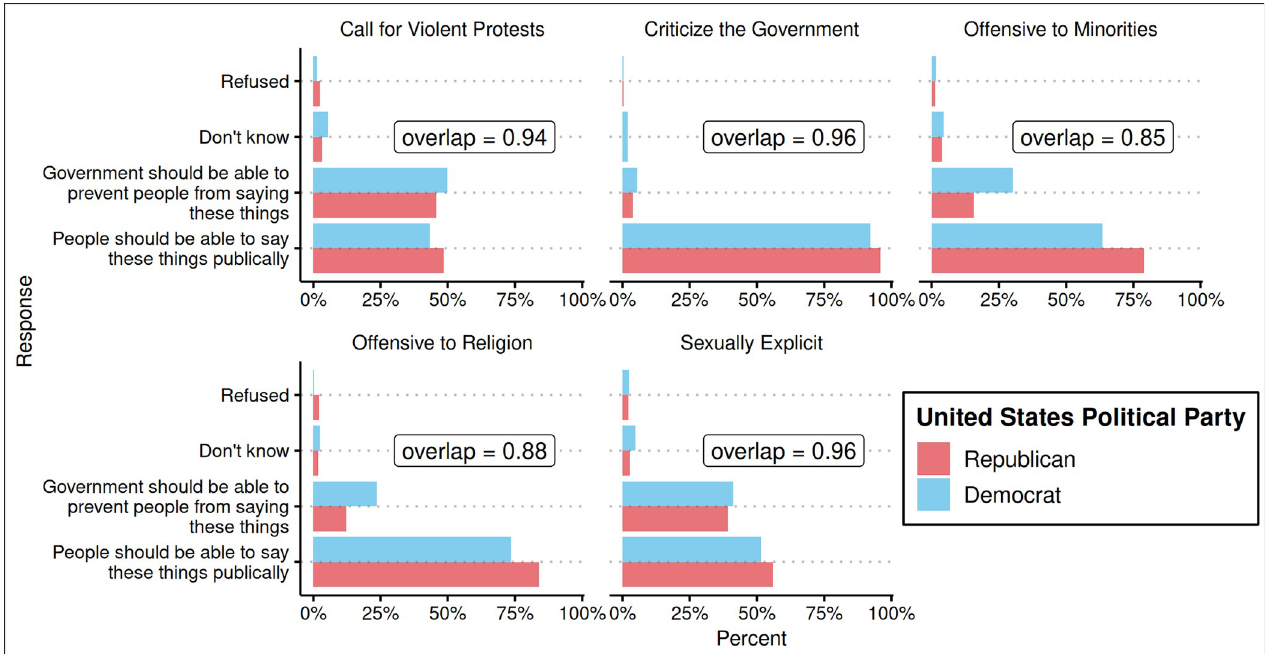
Fig 5. Democrat-Republican overlap for freedom of speech issues.